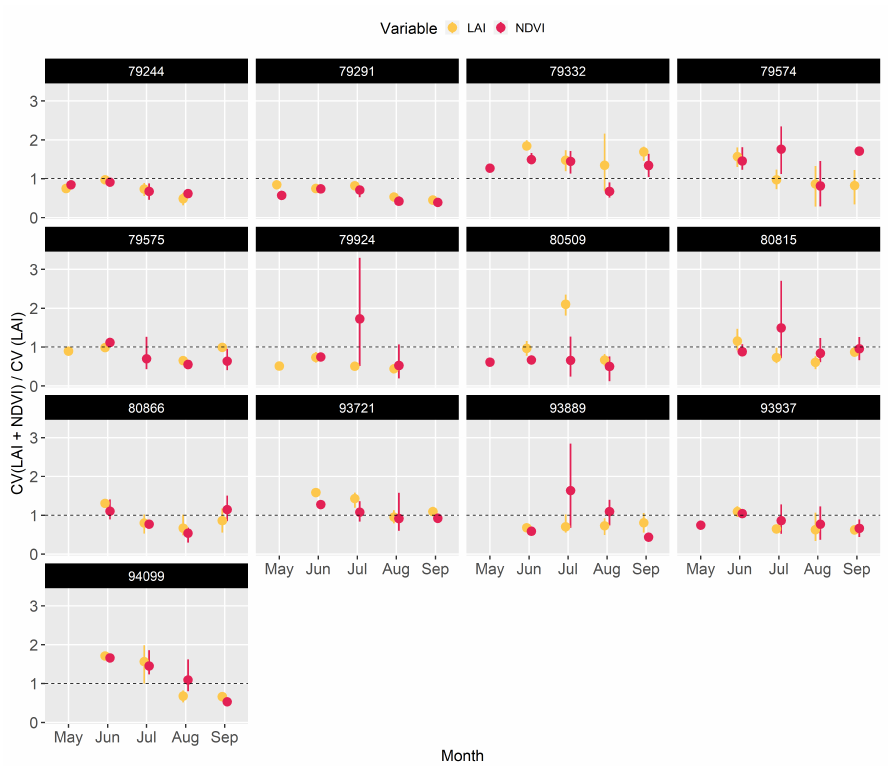
Figure A2. Difference in the posterior distribution of parameters with LAI only, and both LAI and NDVI data constraints in HPDA.